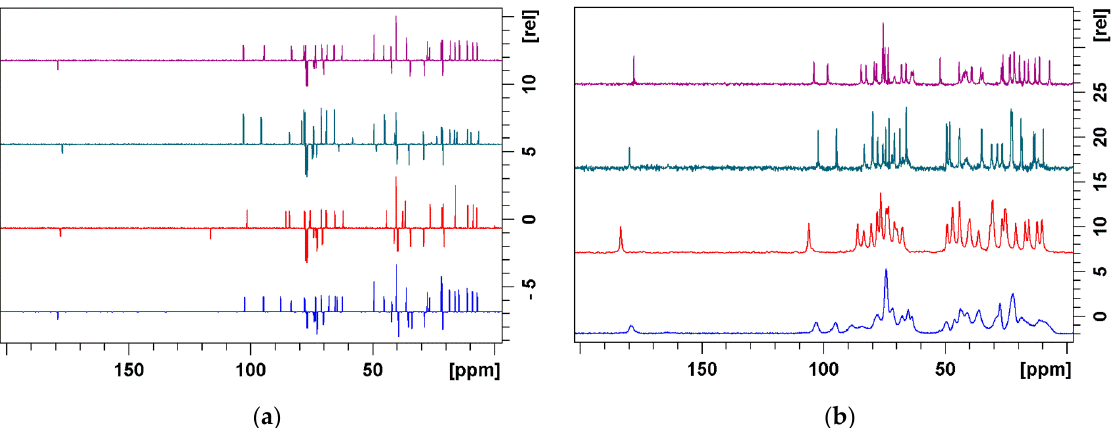
Figure 1. ( a ) Solution − state multiplicity − edited 13 C DEPTQ and ( b ) solid − state 13 C CPMAS NMR spectra of azithromycin, 1a, 1b and 1c (from top to bottom).